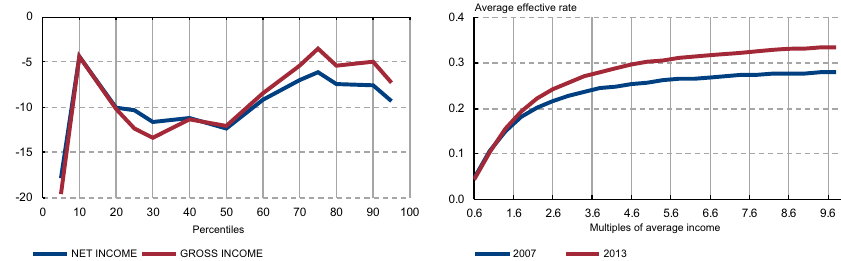
Fig. 12 Changes in net income by percentile. Sources : See notes. a. Source : Banco de España (EFF). b. Source : García-Miralles et al. (2018): “The Spanish Personal Income Tax: Facts and Parametric Estimates,”